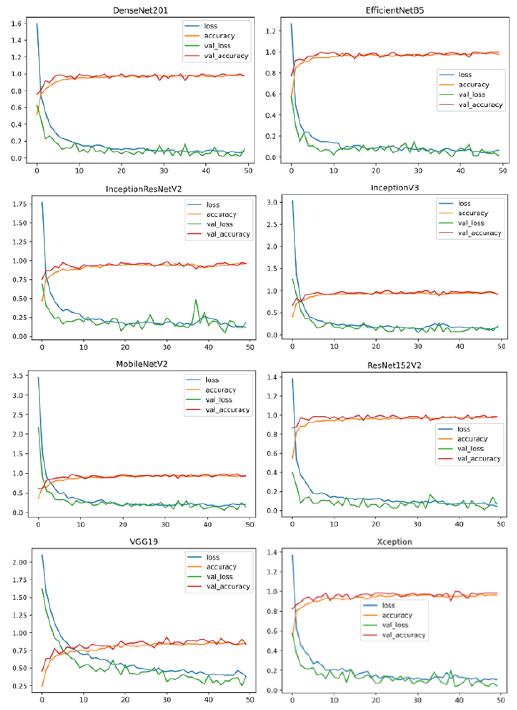
Figure 5: Accuracy, Loss for scene